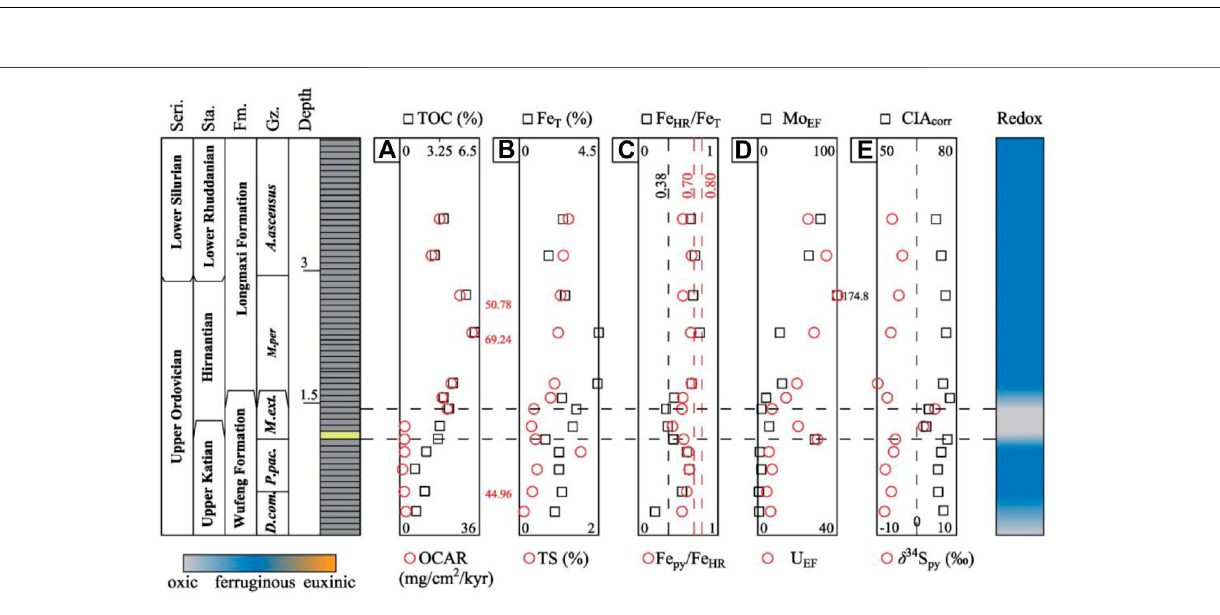
Frontiers in Earth Science |